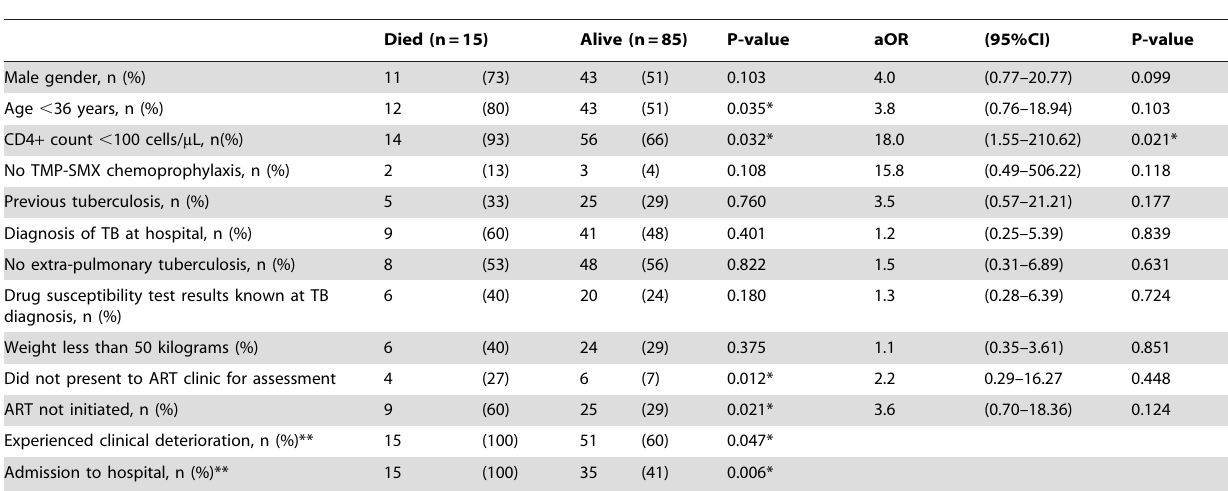
Table 3. Univariate analysis and logistic regression model showing factors associated with death during TB treatment.